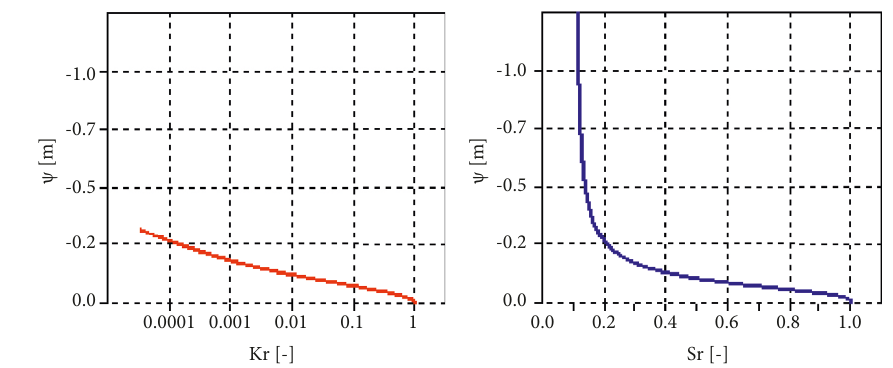
Figure 6: Soil water characteristic curve used in model